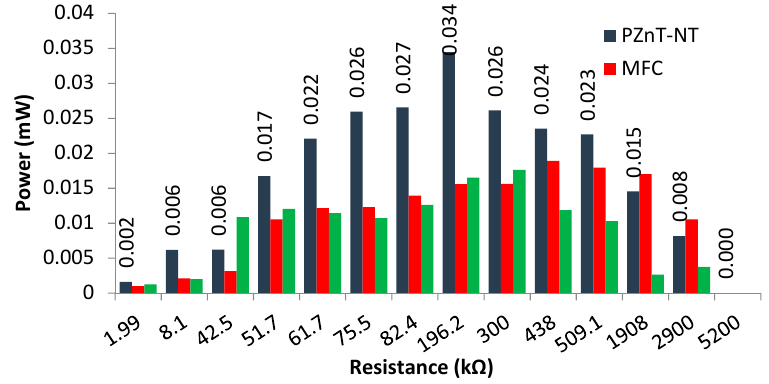
Figure 11. Optimal power output of various harvesters.